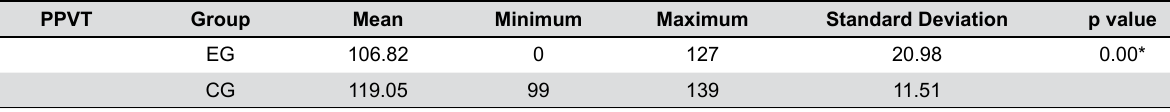
Table 3- Results of the PPVT instrument of the PG compared to the CG